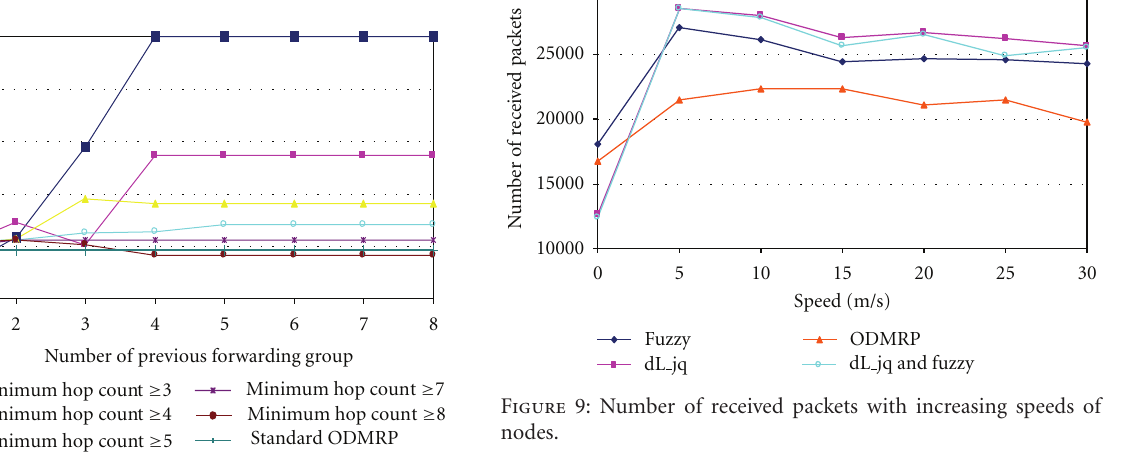
Figure 6: Overall overhead (megabytes) per a data packet.